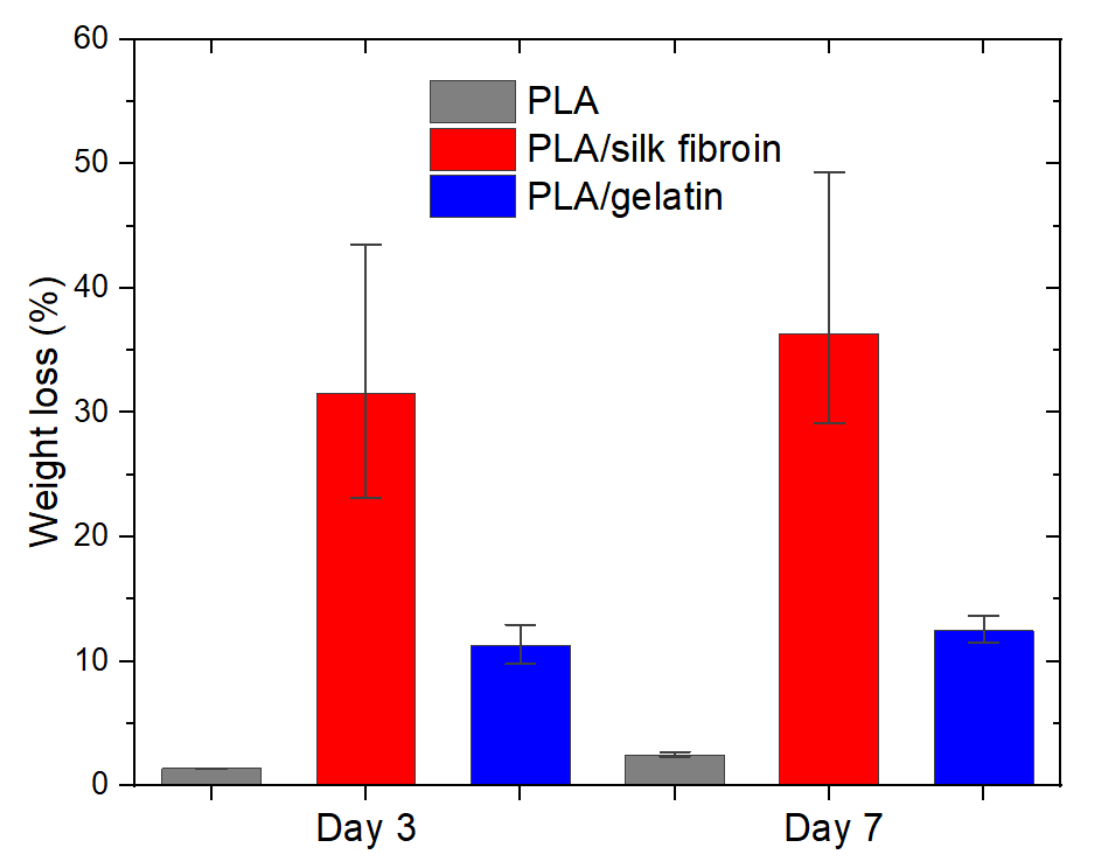
Figure 10. Biodegradation of electrospun PLA and modified PLA scaffolds on day 3 and day 7 after incubation in saline solution.